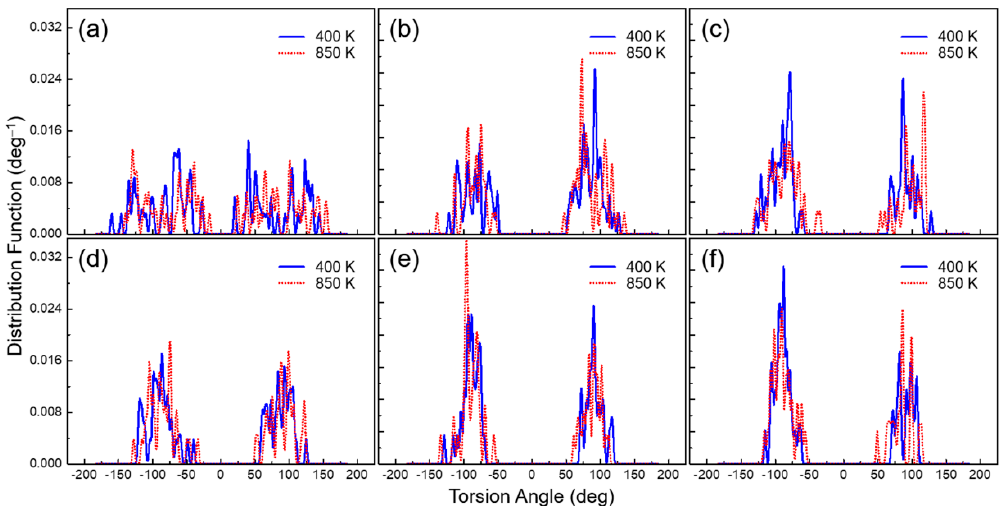
Figure 7. Torsion angle distributions of the PEsI systems obtained from the MD simulations at 400 and 850 K. ( a ) PEsI–(CH 3 ) 1 , ( b ) PEsI–(CH 3 ) 2 , ( c ) PEsI–(CH 3 ) 3 , ( d ) PEsI–(CF 3 ) 1 , ( e ) PEsI–(CF 3 ) 2 , and ( f ) PEsI–(CF 3 ) 3 .